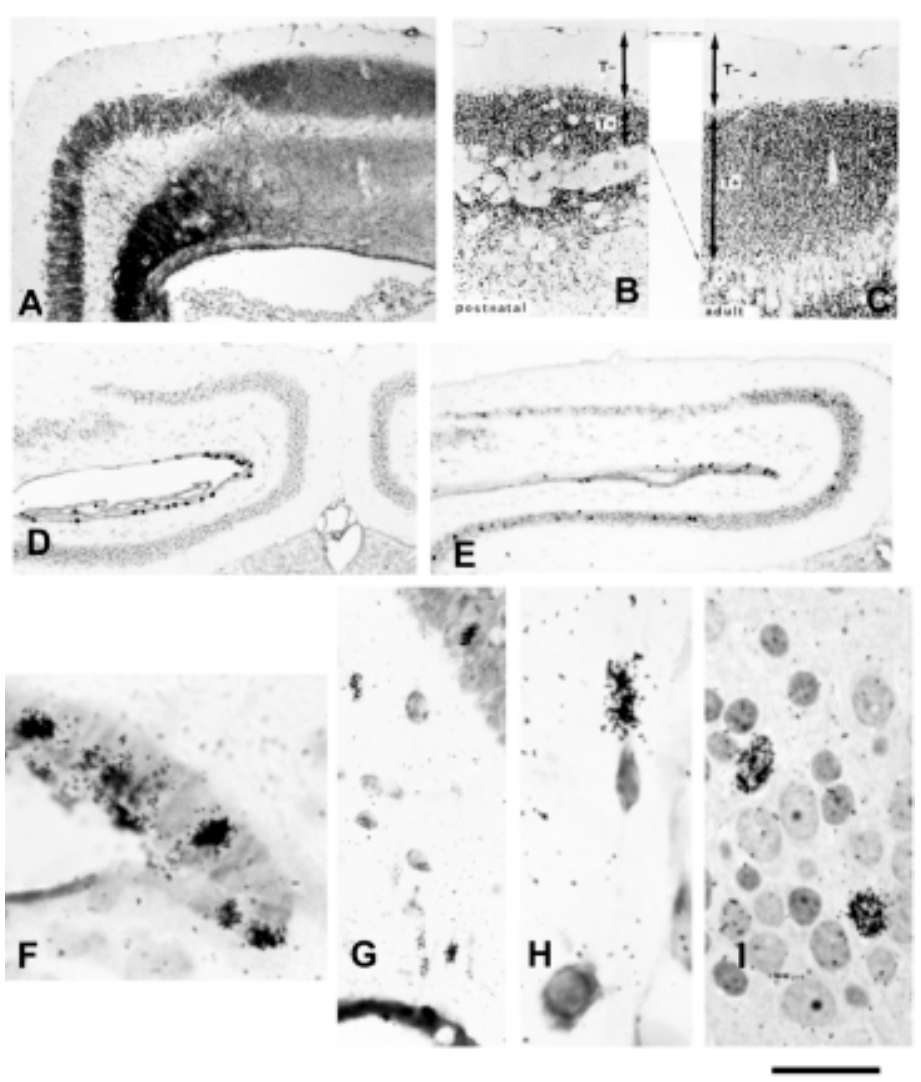
Fig. 3 – Postnatal growth of the lizard medial cortex. A: Lizard cortex transversal section (selenite method) showing both the zinc enriched fields of boutons as well as their parent neurones in the medial cortex cell layer after retrograde labelling of selenium-zinc complexes generated by intraperitoneal injections of sodium selenite five days prior the sacrifice. B-C: aspect of the dorsomedial cortex outer plexiform layer in a postnatal and an adult lizard; observe the increase in the thickness of the zinc positive stratum (T + ) (‘‘lizard stratum lucidum’’) in the adult and the similar thickness of the outer zinc negative (T − ) stratum. D: Autoradiography and toluidine blue counterstaining of a lizard cortex transversal section injected with tritiated thymidine one day before sacrifice; observe the presence of labelled cells in the ependyma. E: Idem, one month after tritiated thymidine injection; observe the presence of labelled cells both in the medial cortex cell layer and also in the ependyma. F: Idem, enlarged view of the medial cortex ependyma (sulcus septoarchicorticalis = septomedialis) one day after tritiated thymidine pulse. G: Idem, one week after tritiated thymidine pulse showing several labelled cells crossing the inner plexiform layer. H: Idem, enlarged aspect of a migratory fusiform labelled cell in the inner plexiform layer. I: Idem, semithin section of the medial cortex cell layer, one month after the tritiated thymidine pulse, showing two labelled nuclei. (Scale bar represents 200 µ m in A, 100 µ m in B and C, 300 µ m in D and E, 50 µ m in G and 20 µ m in F, H and I).